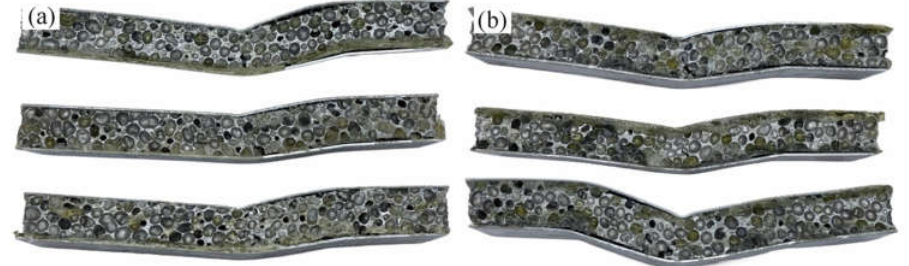
Figure 12. Macroscopic graph of ( a ) failed unreinforced AFS and ( b ) failed short CF reinforced AFS.